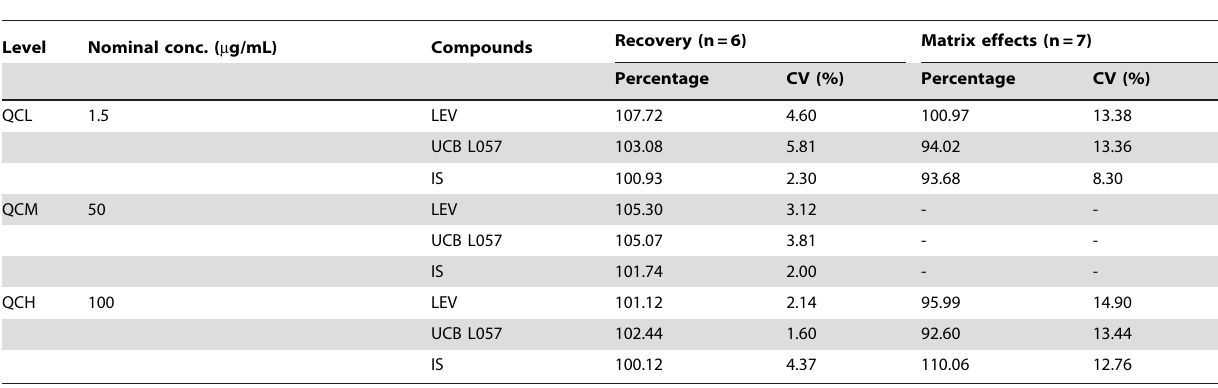
Table 3. Recovery and matrix effects for each analyte.